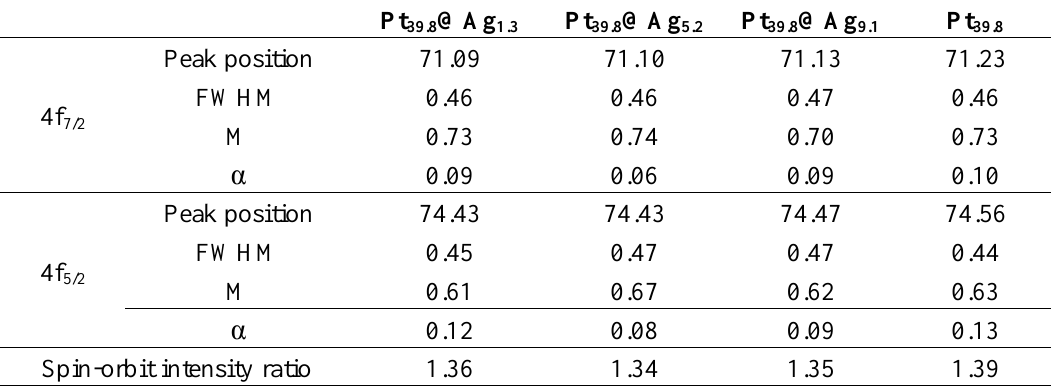
Table 3. Peak parameters obtained by curve fit of Pt 4f peaks using a G-L mixed